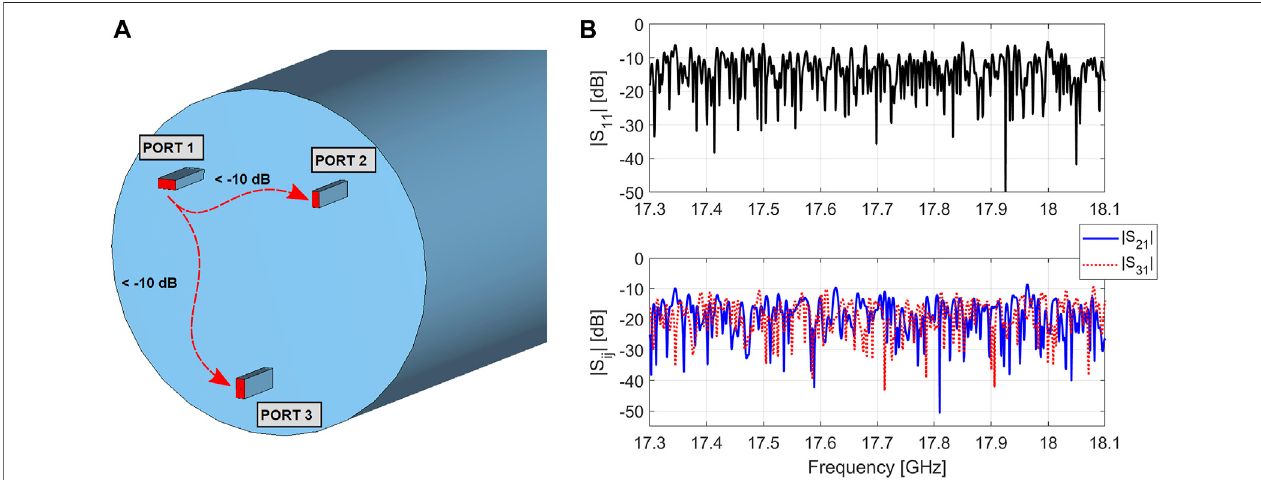
FIGURE 8 | (A) detail of the PANDORA plasma chamber 3D model with its injection waveguides (2 WR62 lines and one WR51 line); (B) | S 11 | and | S ij | parameters obtained considering the vacuum- fi lled plasma chamber, showing that with the employed waveguide ports disposition the cross-talk is minimized.